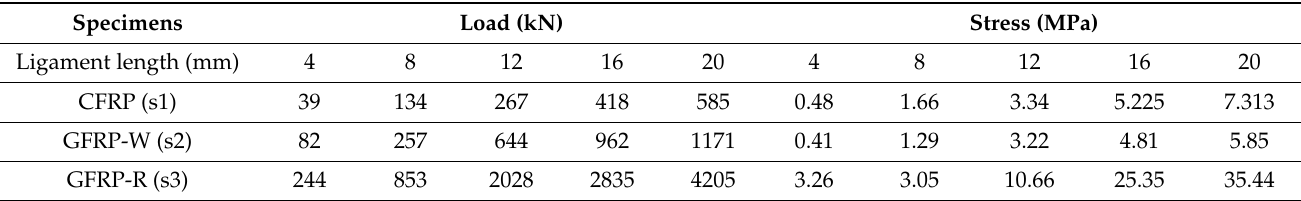
Table 3. Comparing the double edge notch specimens with each ligament length.